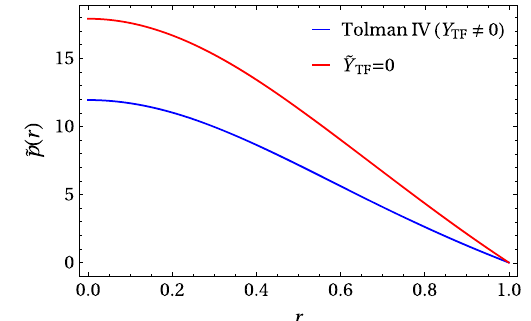
Fig. 4 Radial pressure [ ˜ p × 10 3 ] for the Tolman IV solution ( Y TF (cid:6)= 0) and its anisotropic version with ˜ Y TF = 0 for a distribution with compactness M / R = 0 .